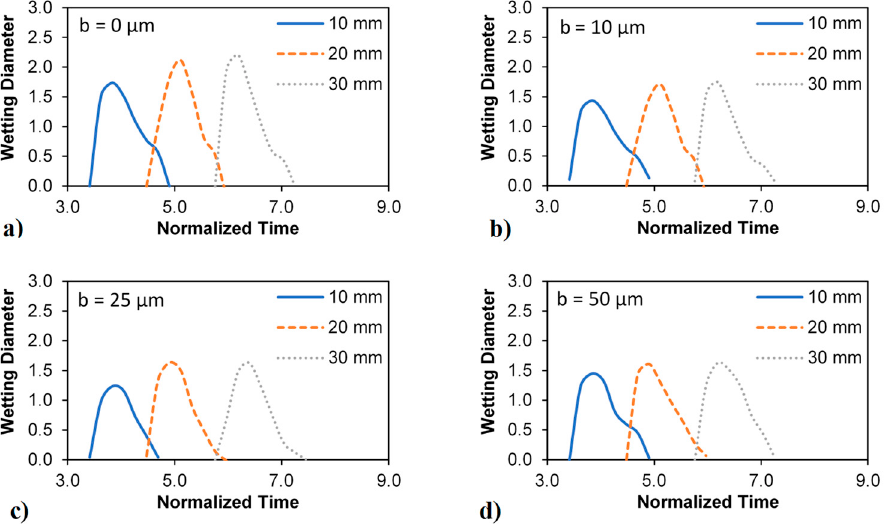
Figure 13. Variation of droplet wetting diameter during impact and rebounding periods for various impact heights and micro-post spacings: ( a ) flat hydrophobized surface b = 0 µ m, ( b ) b = 10 µ m, ( c ) b = 25 µ m, ( d ) b = 50 µ m. Droplet volume is 10 µ L.